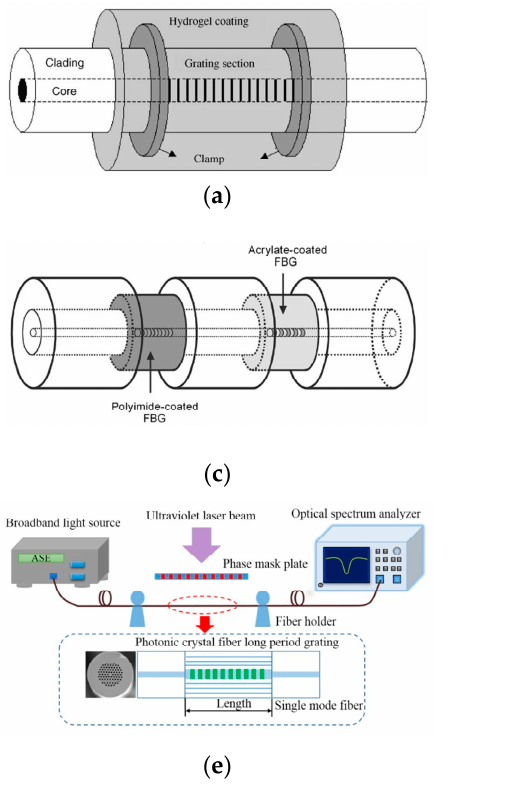
Figure 5. ( a ) Structure of the hydrogel-coated FBG sensor [42]. ( b ) Structure of the hydrogel-coated etched FBG sensor [43]. ( c ) Illustration of the multiplexed FBG sensor system [41]. ( d ) Diagram of the fusing process at different stages [47]. ( e ) Schematic of the measurement system and its sensing structure [49]. ( f ) Schematic of the measurement system of sensing sensitivity [53].